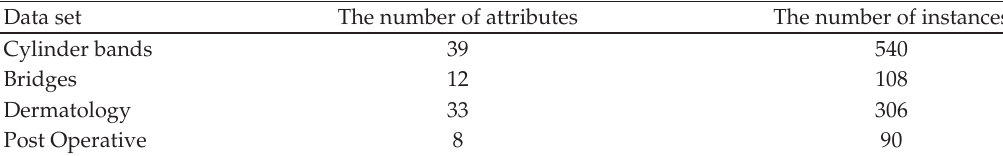
Table 6: The number of attributes and instances of data